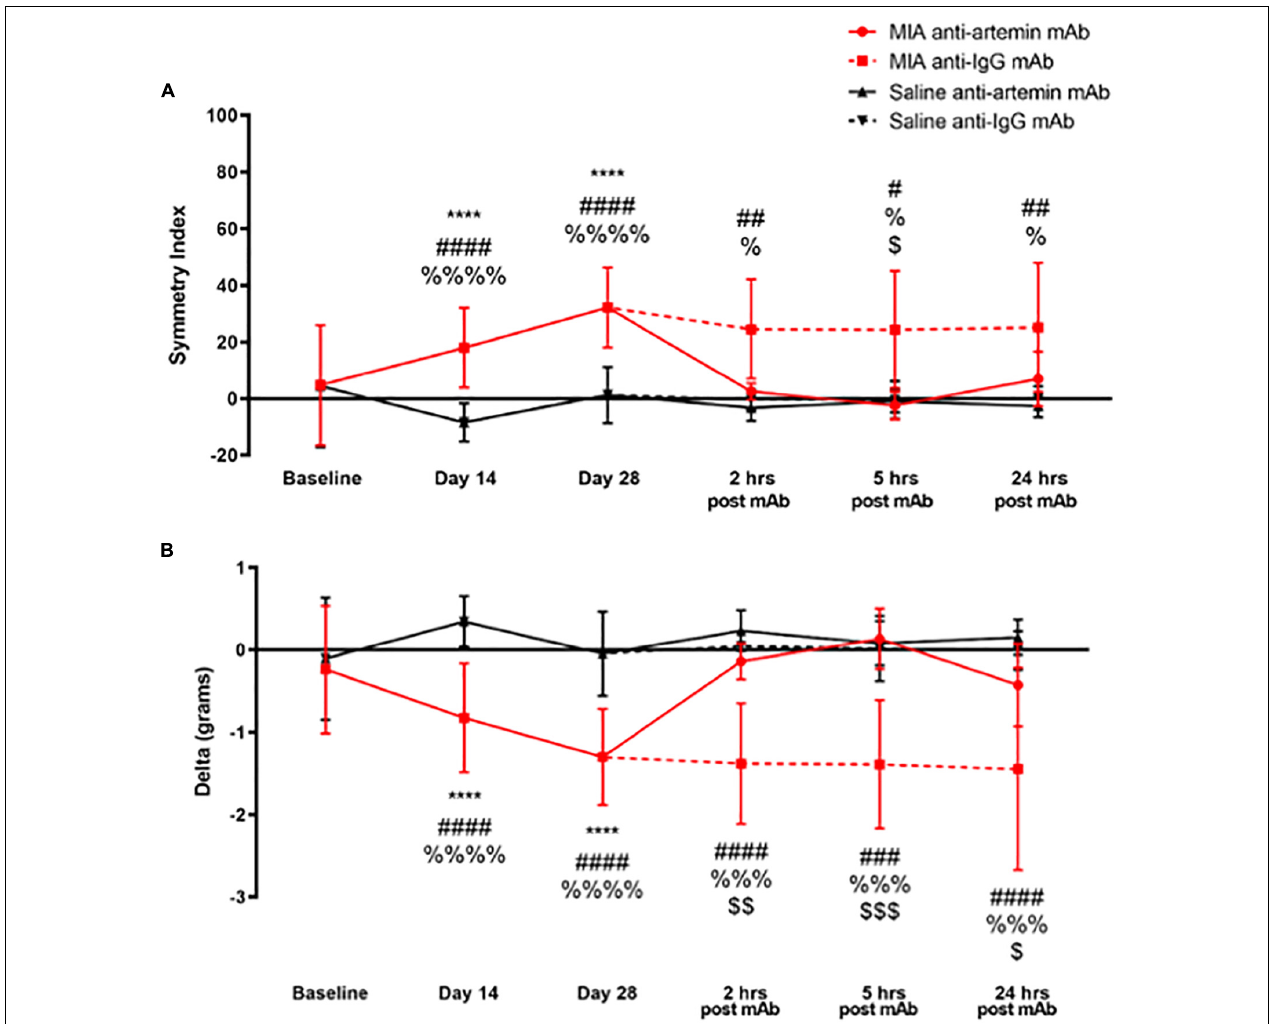
FIGURE 7 | An anti-artemin antibody rescues MIA-induced limb asymmetry. Hind limb Symmetry Index (A) , and Delta or the difference between the weight placed on the MIA-injected right and control left legs (B) was determined at baseline, days 14, 28 and 2-, 5-, and 24-h after systemic anti-artemin or anti-IgG monoclonal antibody administration. The anti-artemin antibody reversed MIA-induced limb asymmetry and returned Delta to baseline values at 2-, 5-, and 24-h post-antibody administration compared with the isotype control group. Asterisk compares MIA/anti-artemin and saline anti-artemin and anti-IgG groups, # compares MIA/anti-IgG and saline/anti-artemin, % compares MIA/anti-IgG and saline/anti-IgG, $ compares MIA/anti-artemin and MIA/anti-IgG groups. Baseline (MIA males n = 8, MIA females n = 0, saline males n = 8, saline females n = 0), day 14 (MIA males n = 7, MIA females n = 5, saline males n = 8, saline females n = 7), day 28 (MIA males n = 7, MIA females n = 5, saline males n = 8, saline females n = 6), 2–24 h (MIA anti-artemin males n = 3, MIA anti-artemin females n = 2, MIA anti-IgG males n = 2, MIA anti-IgG females n = 2, saline anti-artemin males n = 3, saline anti-artemin females n = 4, saline anti-IgG males n = 3, saline anti-IgG females n = 3). Data are represented as mean ± SD ( # , % , and $ p < 0.05; ## and $$ p < 0.01; ### , %%% , and $$$ p < 0.001; ****, #### , and %%%% p < 0.0001). Two-way ANOVA with repeated measures and Holm-Sidak multiple comparisons